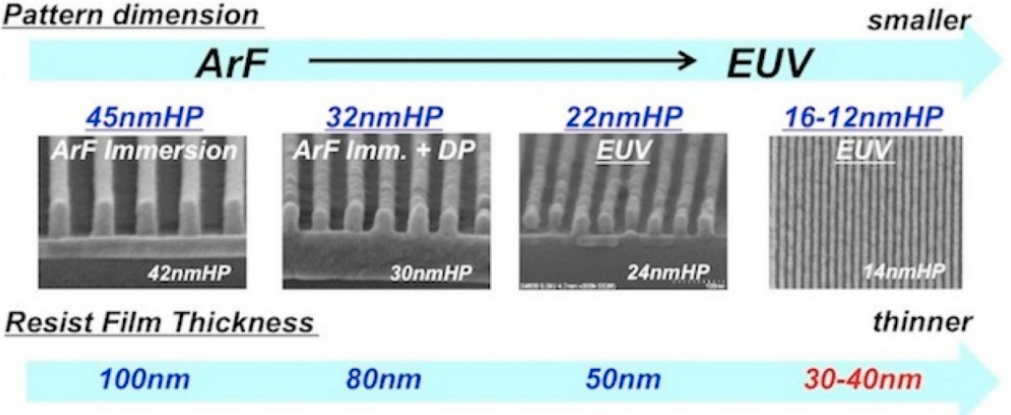
Figure 4. Evolution of the lithography technique where the pattern becomes denser and smaller in each new technology node. To prevent pattern collapse, the thickness of resist is reduced proportionally to the minimum half-pitch (HP) of lines/spaces.